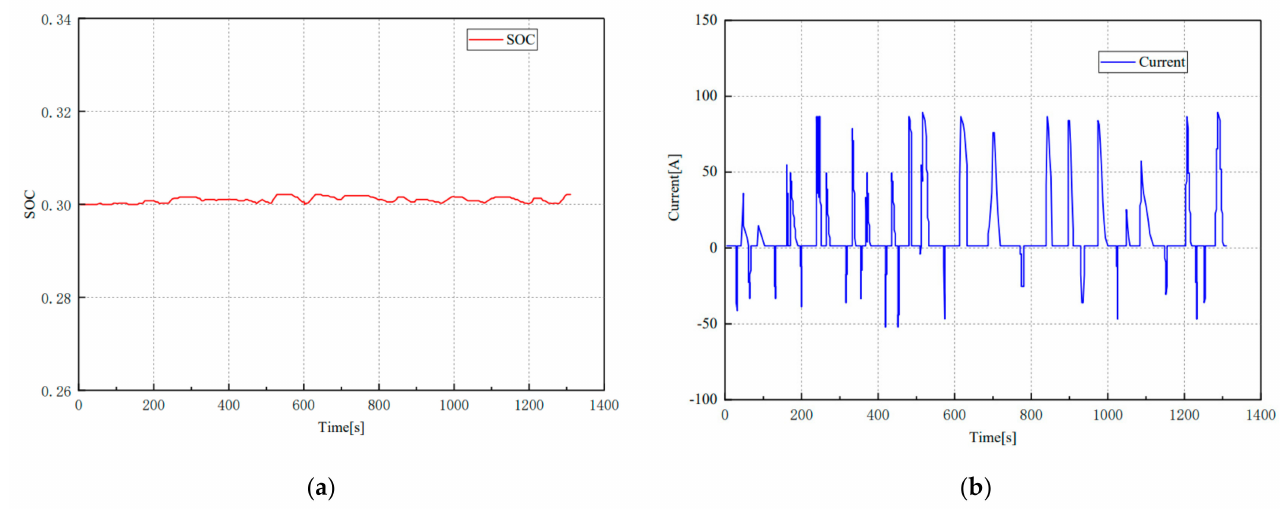
Figure 11. Battery SOC and battery output current as a function of time. ( a ) Battery SOC. ( b ) Battery output